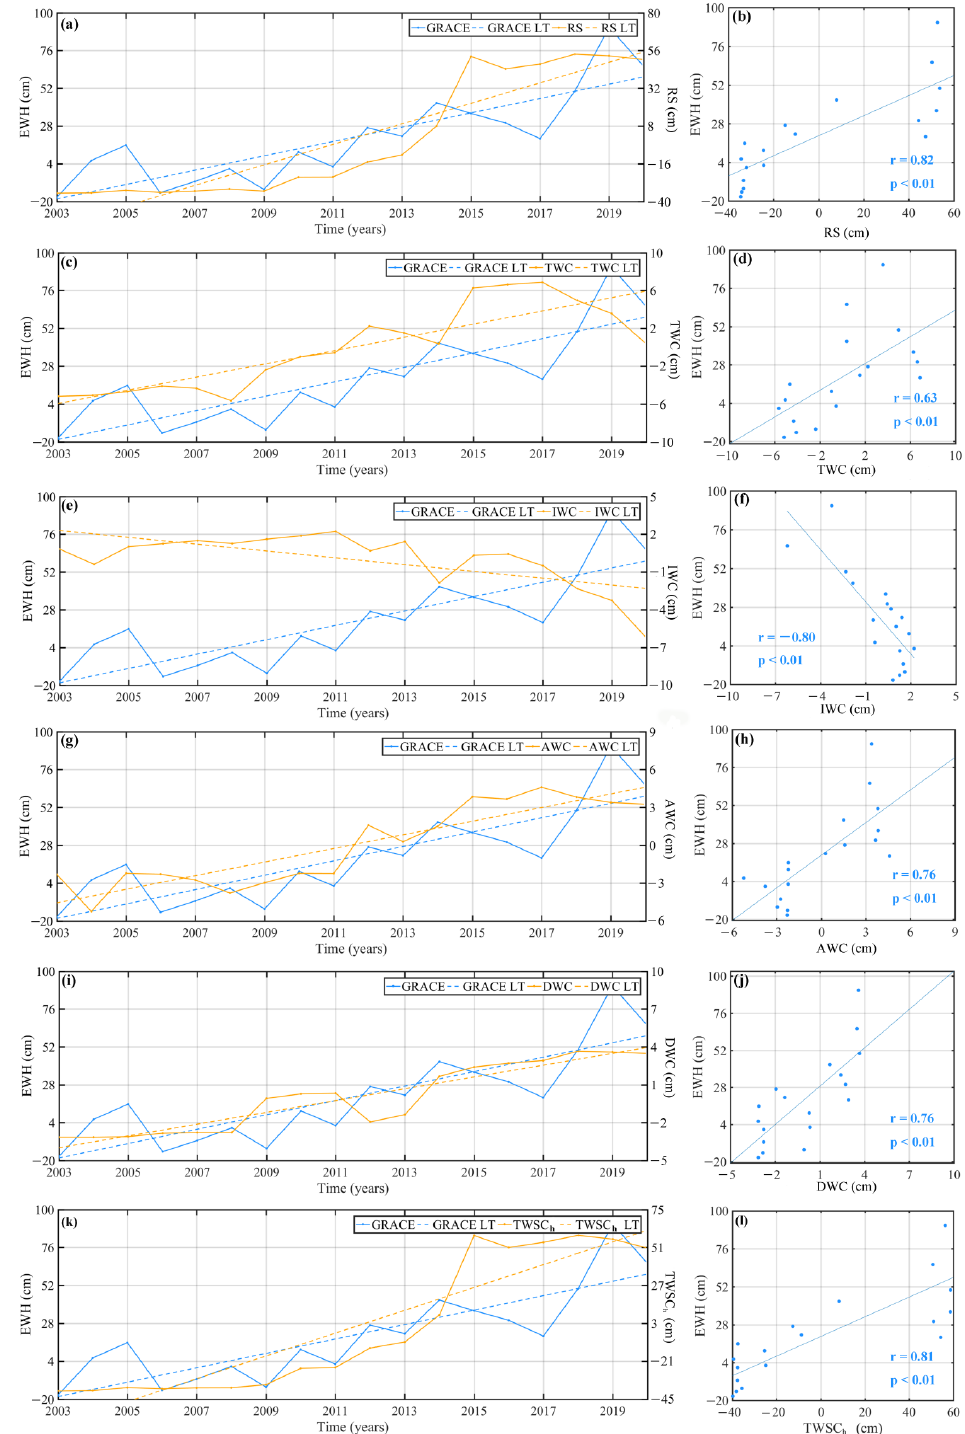
Figure 10. The relationships between monthly TWSC and RS, TWC, IWC AWC, DWC and TWSC h , respectively, in Sichuan. RS: reservoir storage; TWC: total water consumption; IWC: industrial water consumption; AWC: agriculture water consumption; DWC: domestic water consumption. ( a , c , e , g , i , k ) show the time series and long-term trend changes of RS, TWC, IWC AWC, DWC and TWSC h , respectively; ( b , d , f , h , j , l ) show the correlation coefficient between TWSC and RS, TWC, IWC AWC, DWC, TWSC h ,